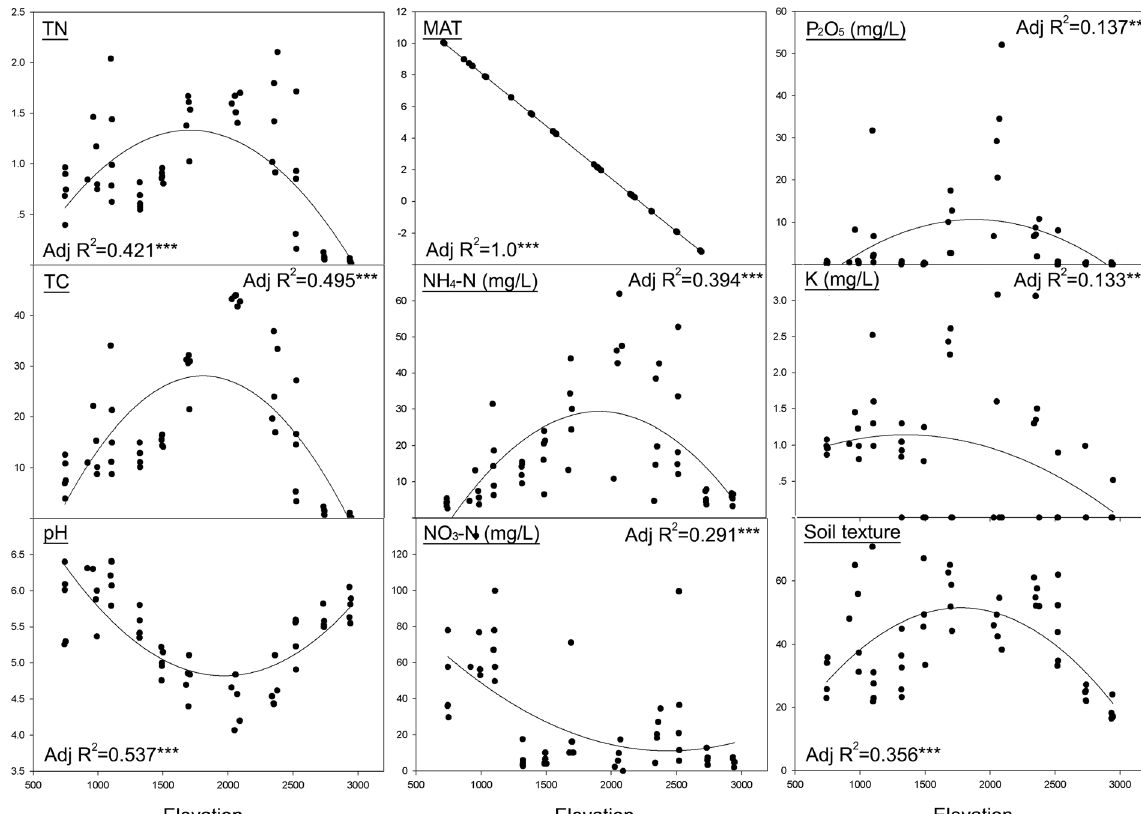
Figure 6. Physicochemical factors shown in relation to elevation. Model selection was carried out based on adjusted R 2 and root mean square error and only the significant ones are reported. The values of TC and TN are shown in percentages. Total of percentage silt and clay content are used to indicate soil texture.